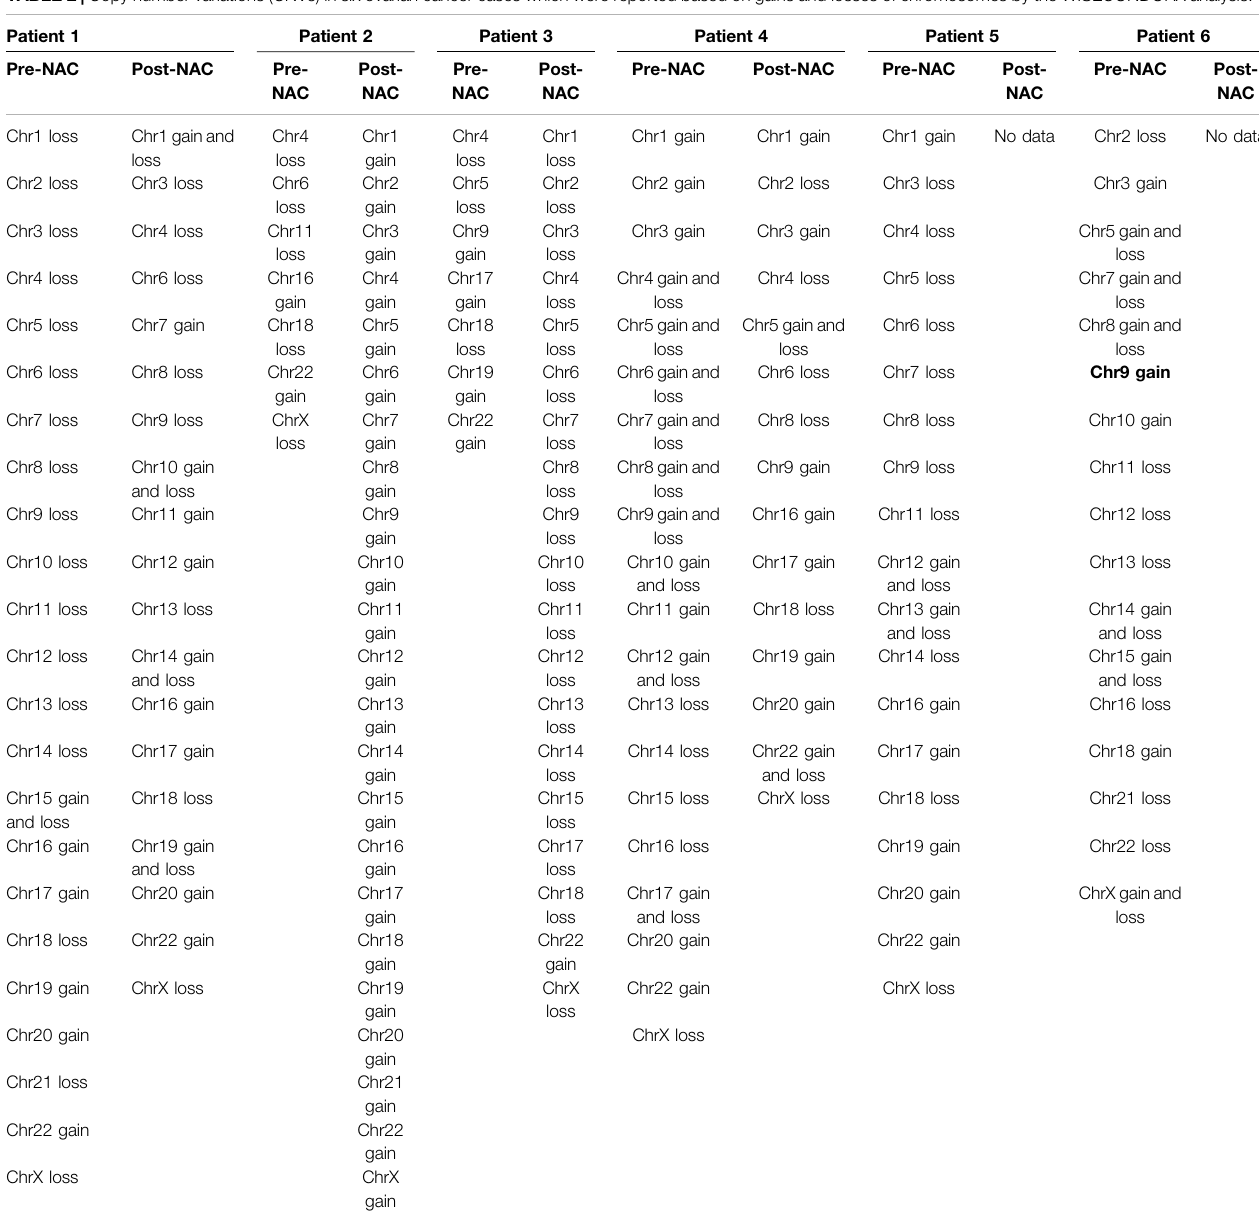
TABLE 2 | Copy number variations (CNVs) in six ovarian cancer cases which were reported based on gains and losses of chromosomes by the WISECONDORX analysis. Patient